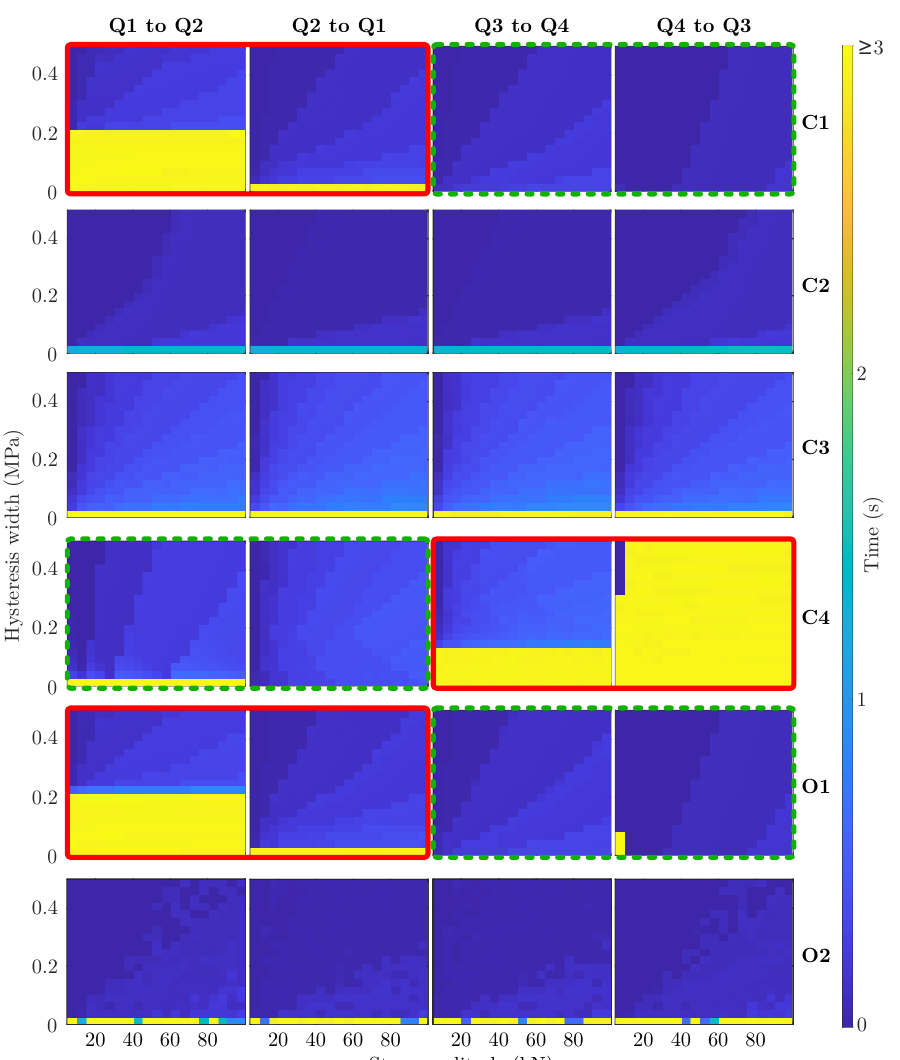
Figure 15. Time between first and last switch when a step in external force is applied for different quadrants and different configurations. The step was applied after 2 s and the simulation ran for 5 s, meaning that the maximum switching time was 3 s. The cases with negative pressure-drop hysteresis are marked with solid red lines and the ones with positive are marked with dashed green